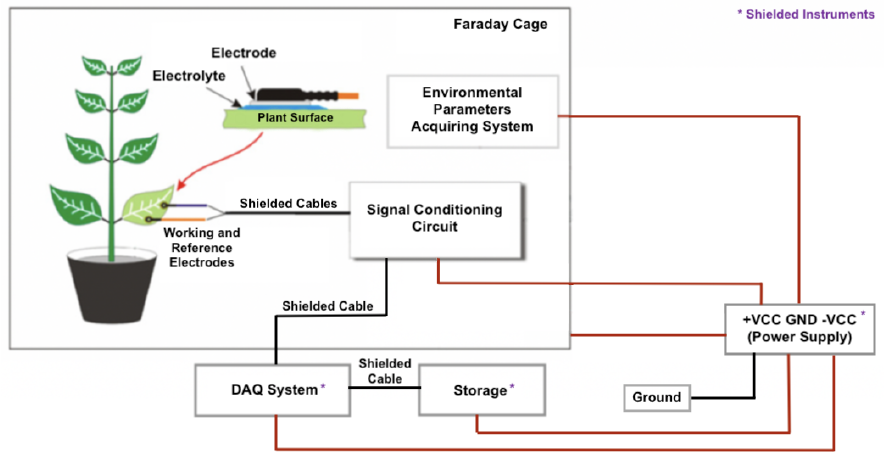
Figure 2. The complete acquisition system for measuring plants electrical responses